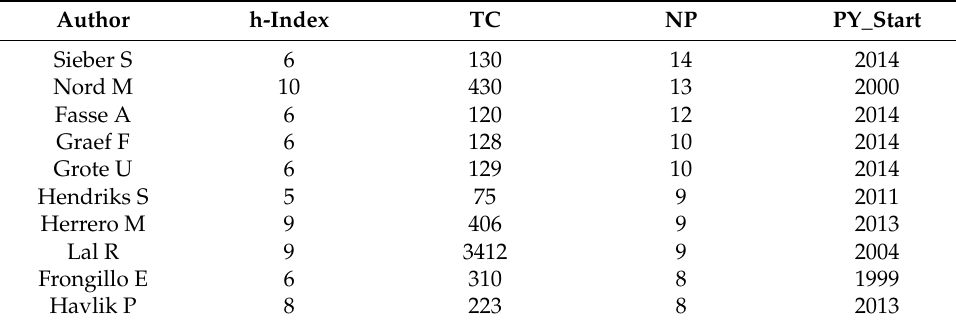
Table 1. Top 10 authors in the field of food security research.